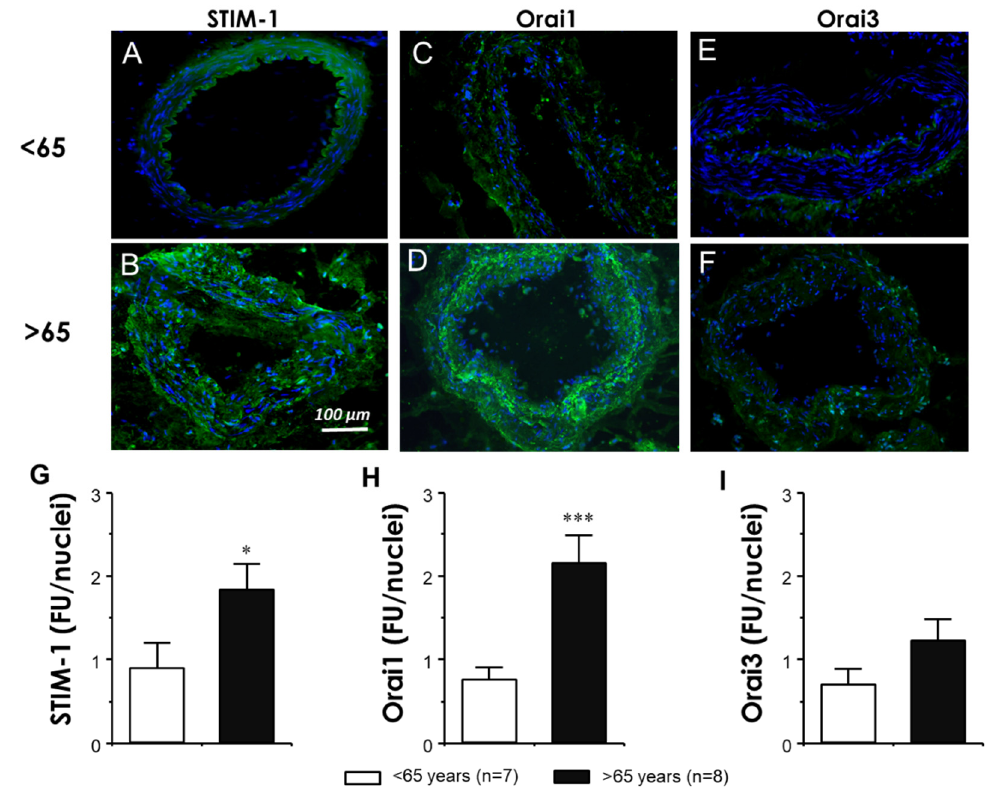
Figure 3 . STIM-1 and Orai1 are up-regulated in human aged mesenteric arteries. Upper panel shows the representative immunofluorescence images for detection (green fluorescence) of STIM-1 ( A , B ); Orai1 ( C , D ) and Orai3 ( E , F ) in cryosections of mesenteric arteries from organ donors younger than 65-years old ( A , C , E ) and older than 65-years old ( B , D , F ). Nuclei are counterstained in blue. Magnifications: × 100. Quantification of expression assays for STIM-1, Orai1, and Orai 3 are displayed in panels ( G – I ), respectively. Data are expressed as mean ± SEM of STIM/Orai arbitrary units of fluorescence intensities normalized by number of nuclei. n indicates the number of subjects from which the tissues were obtained for the experiments. * p < 0.05, *** p < 0.001 vs. <65-year-old group by unpaired t -test.